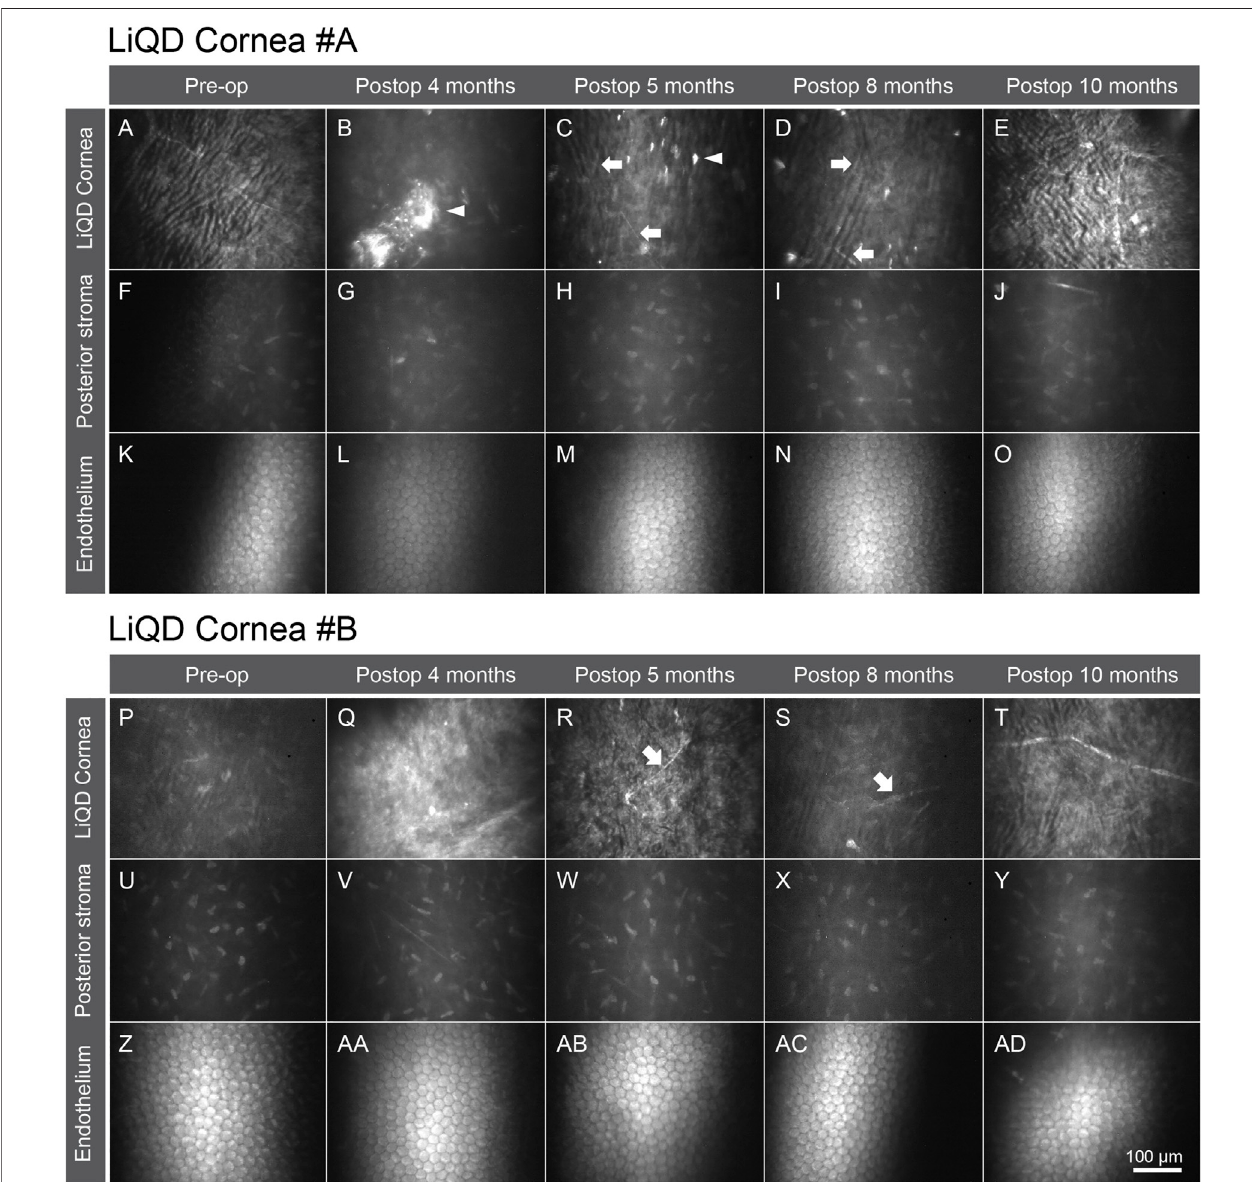
FIGURE5| In vivo confocal microscopyofanimal #A. Normal corneabeforesurgery (A, F, K) and progressive replacement oftheLiQD cornea matrix. Emergence of numerous re fl ective keratocytes within the fi ller was documented 4 months after surgery (B) , as well as fi ne nerve fi bers (arrows) 1 month later (C) , along with progressive loss of the highly re fl ective remnants of the fi ller (arrow heads) (B – D) . At 10 months, the neo-stroma replacing the fi ller (E) looked very much like the preoperative native stroma. The posterior stroma (F – J) and the corneal endothelium (K – O) remained intact throughout the entire study period. In vivo confocal microscopy of animal #B. Normal cornea before surgery (P, U, Z) . Filler appearance at 4 months postop (Q) showing numerous re fl ective remnants of the fi ller. Emergence of keratocytes and nerve fi bers (arrows) within the fi ller at 5 months postop (R, S) . At 10 months postop, the implanted stroma returned to a stable state similar to normal (T) . The posterior stroma (U – Y) and the corneal endothelium (Z – AD) remained intact throughout the entire study period.